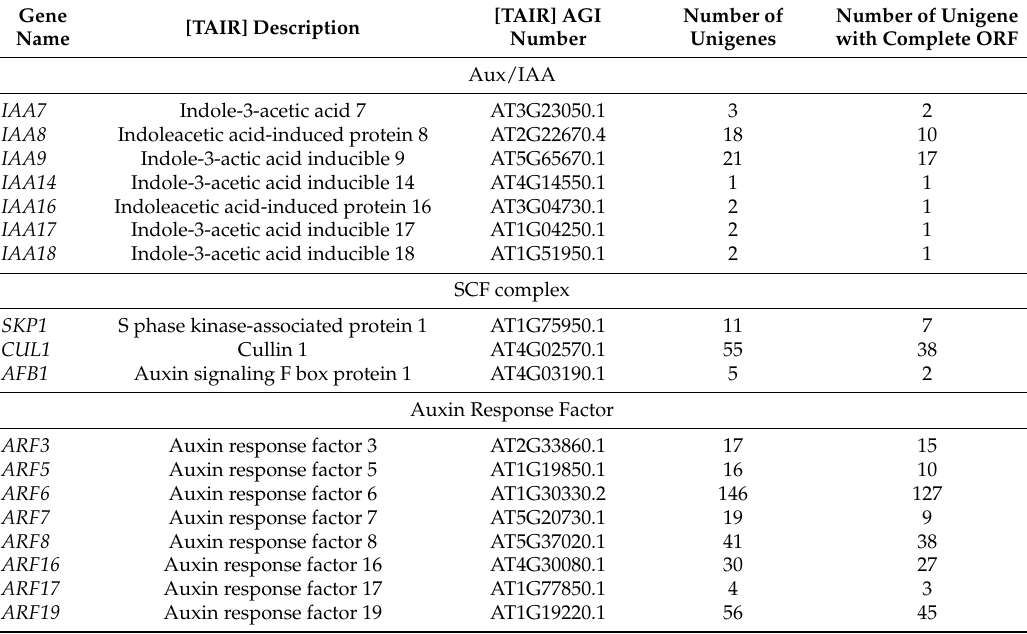
Table 2. Unigenes involved in auxin signal components in P. ginseng .